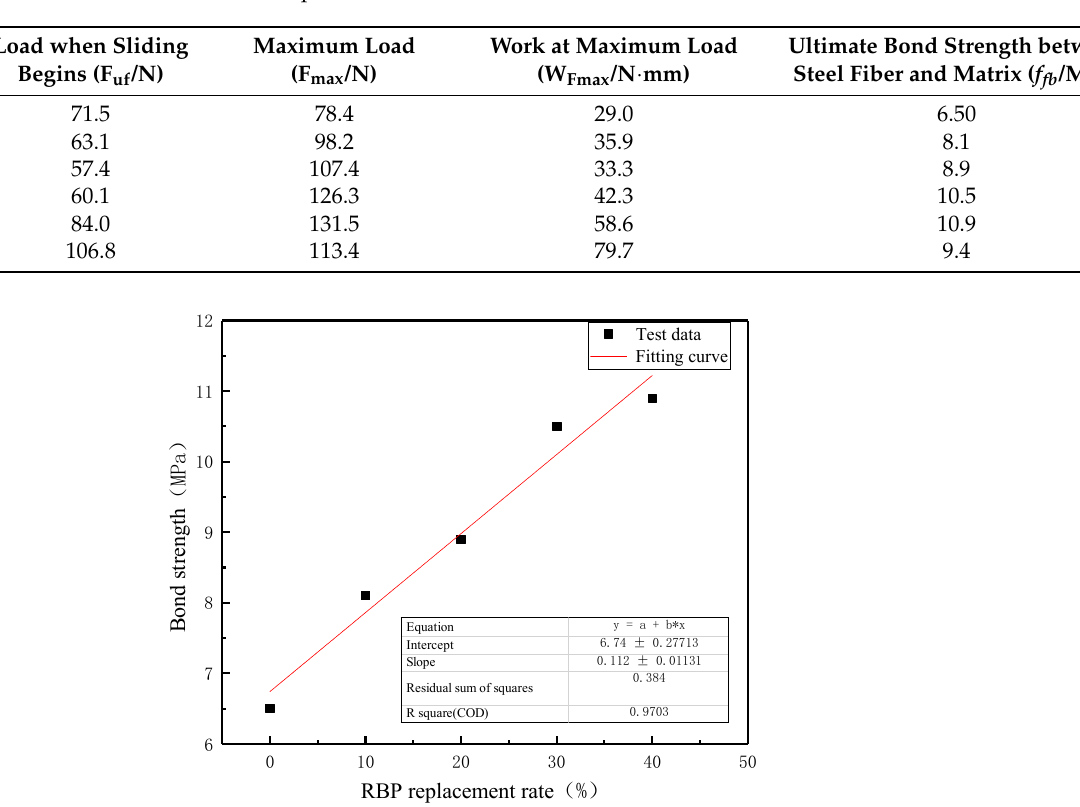
Table 9. Fiber pull-out test results.